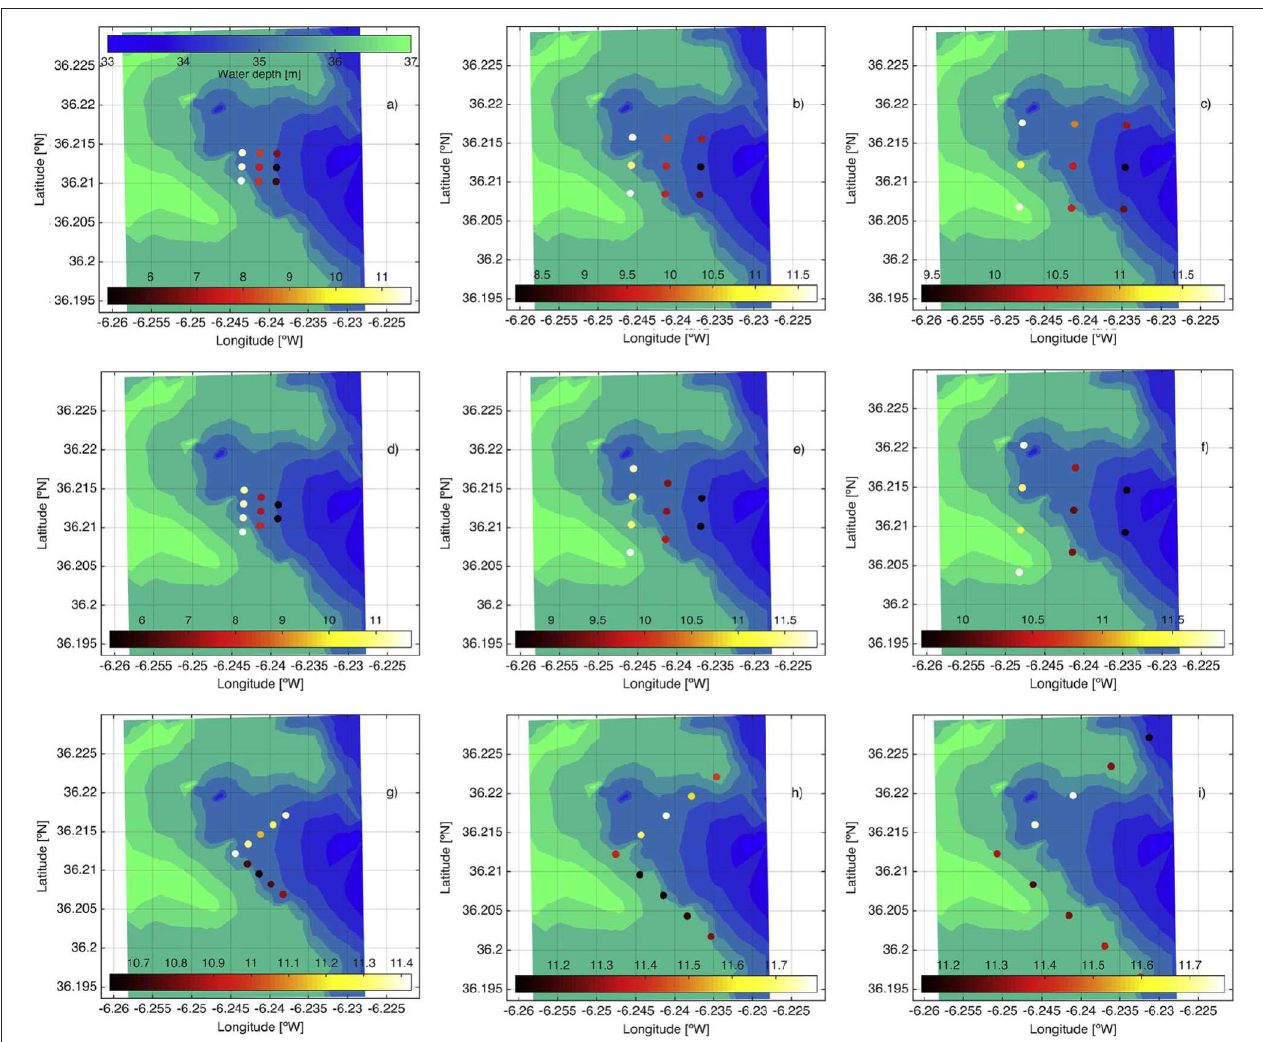
FIGURE 3 | Average absorbed power for aligned, staggered, and arrow arrays with three different separation distances (López-Ruiz et al., 2018a). The arrow layouts (bottom row) perform better than the other two, with an average power per WEC of 11–12 kW/m.